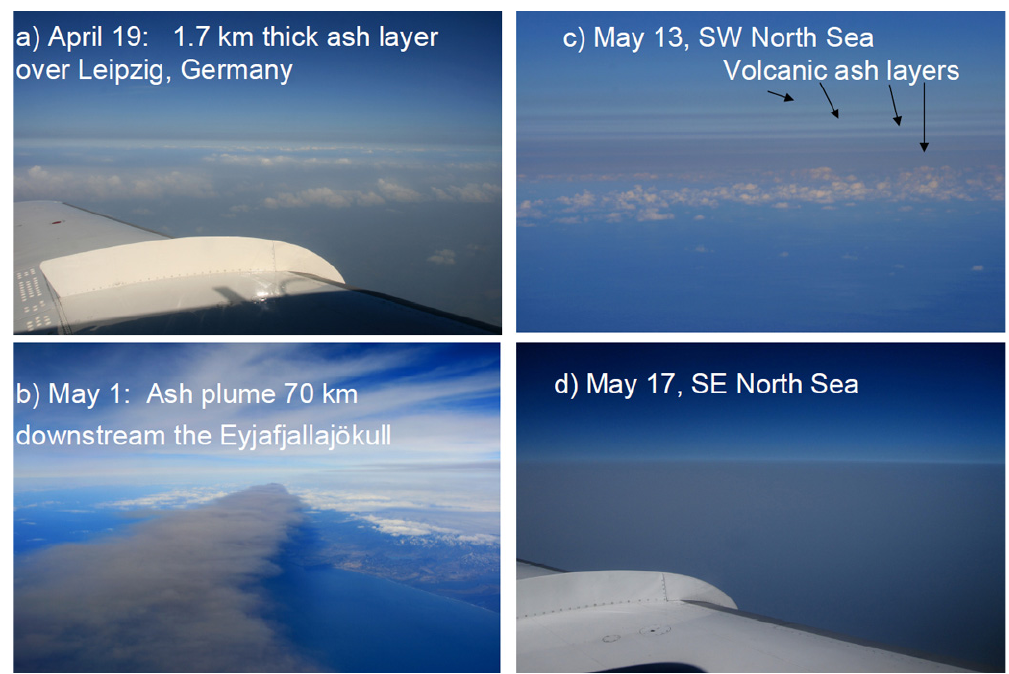
Fig. 10. Photos showing elevated volcanic ash layers ( a and c ), the fresh VA plume (b) and a deep VA layer (d) at various times and positions, and with various viewing directions as indicated. (a) 15:07UTC 19 April 2010, 51.51 ◦ N, 12.44 ◦ E, 4.25km, west. (b) 12:49UTC 1 May, 63.18 ◦ N, 18.67 ◦ W, 6.7km, northwest. (c) 14:09UTC 13 May, 53.59 ◦ N, 1.04 ◦ E, 5.16km, west. (d) 15:54UTC 17 May, 52.70 ◦ N, 2.83 ◦ E, 6.39km, southwest. The positions are identified in Fig.